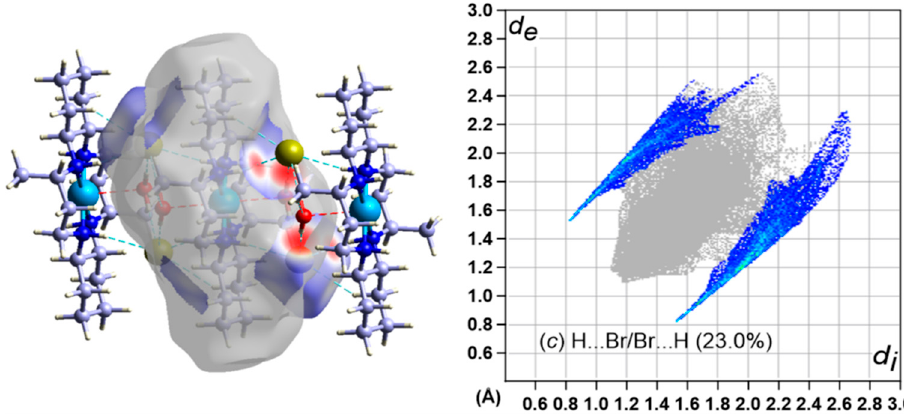
Figure 8. Hirshfeld surface mapped with ( left ) d norm , and 2D fingerprint plot ( right ) for H···Br/Br···H interactions.